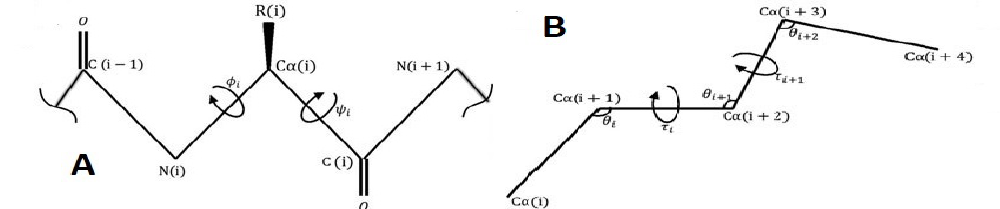
Figure 1. Two representations of protein backbone structures based on torsion or pseudo-torsion